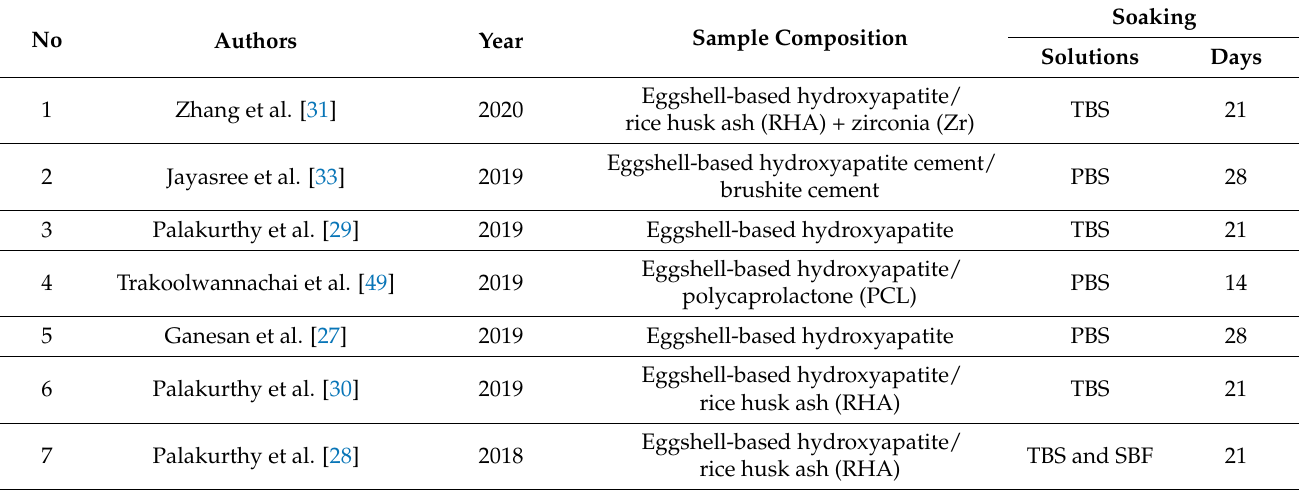
Table 1. In vitro degradation test data based on various soaking solutions and